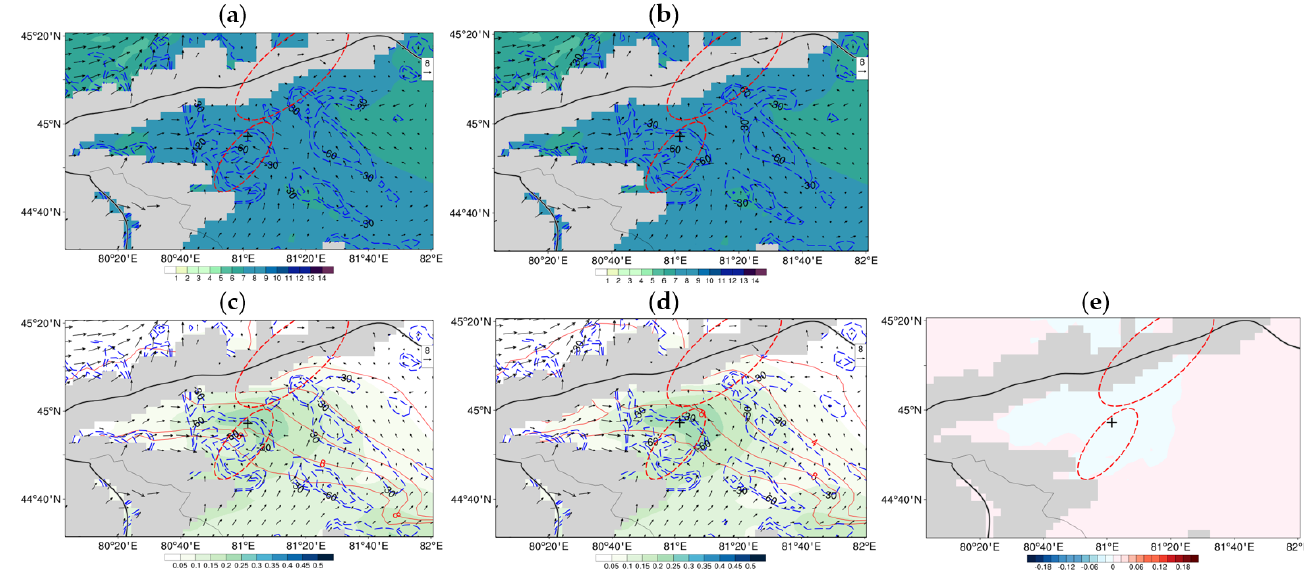
Figure 10. Horizontal cross-section of the analysis and the increment of water vapor (unit g/kg) at 0800 UTC at 3000m. ( a ) The analysis from C2Rad. ( b ) The analysis from C2RadBy. ( c ) The increment from C2Rad. ( d ) The increment from C2RadBy. ( e ) The difference of increment between C2Rad and C2RadBy. The shades in each plot indicate the water vapor mixing ratio (unit g/kg). The solid red lines indicate the increment of temperature (unit 0.001 ◦ C). The dashed blue lines indicate the analysis of negative divergence (unit 1/s). The ellipse of dashed red lines indicates the main areal coverage of precipitation which is the same